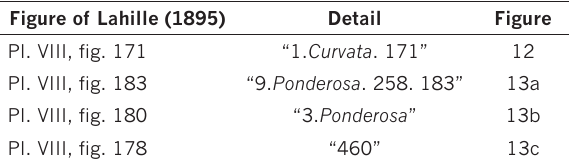
Table 3. Voluta ancilla ponderosa , specimens from the MLP Collection figured by Lahille (1895) with the details of the in - scriptions on their shells and figures here.